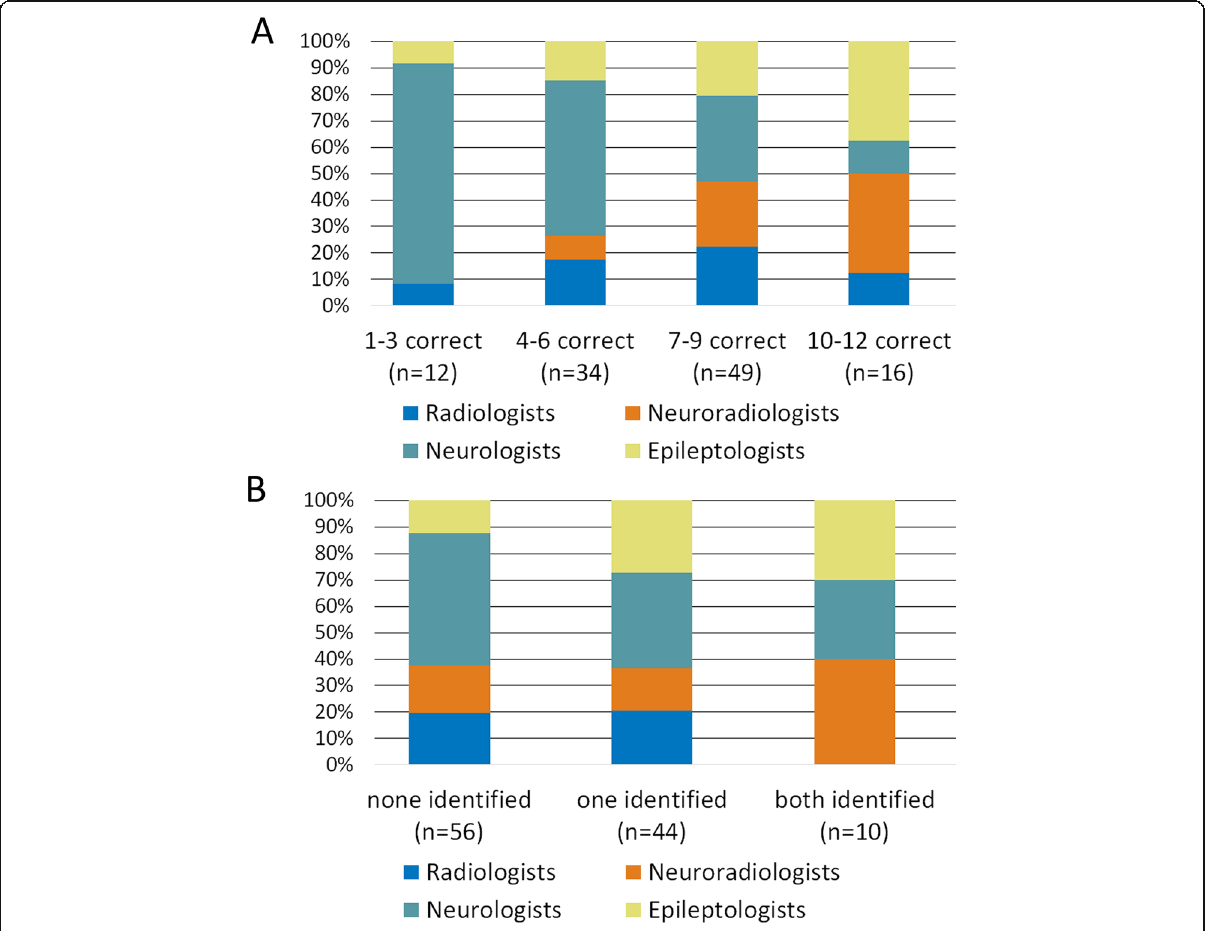
Fig. 2 MRI - reading performance of medical specialties across all lesion entities (A), and focal cortical dysplasias only (B). Legend: A: Relative proportions of medical specialties among “ poor ” (1 – 3 correct diagnoses), “ moderate ” (4 – 6 correct diagnoses), “ good ” (7 – 9 correct diagnoses) and “ very good ” (10 – 12 correct diagnoses) MRI readers in percent across all MRIs presented. B: Relative proportions of medical specialties among 0, 1 and 2 correctly identified focal cortical dysplasias. One participant who reviewed only one MRI containing a focal cortical dysplasia was not included in this